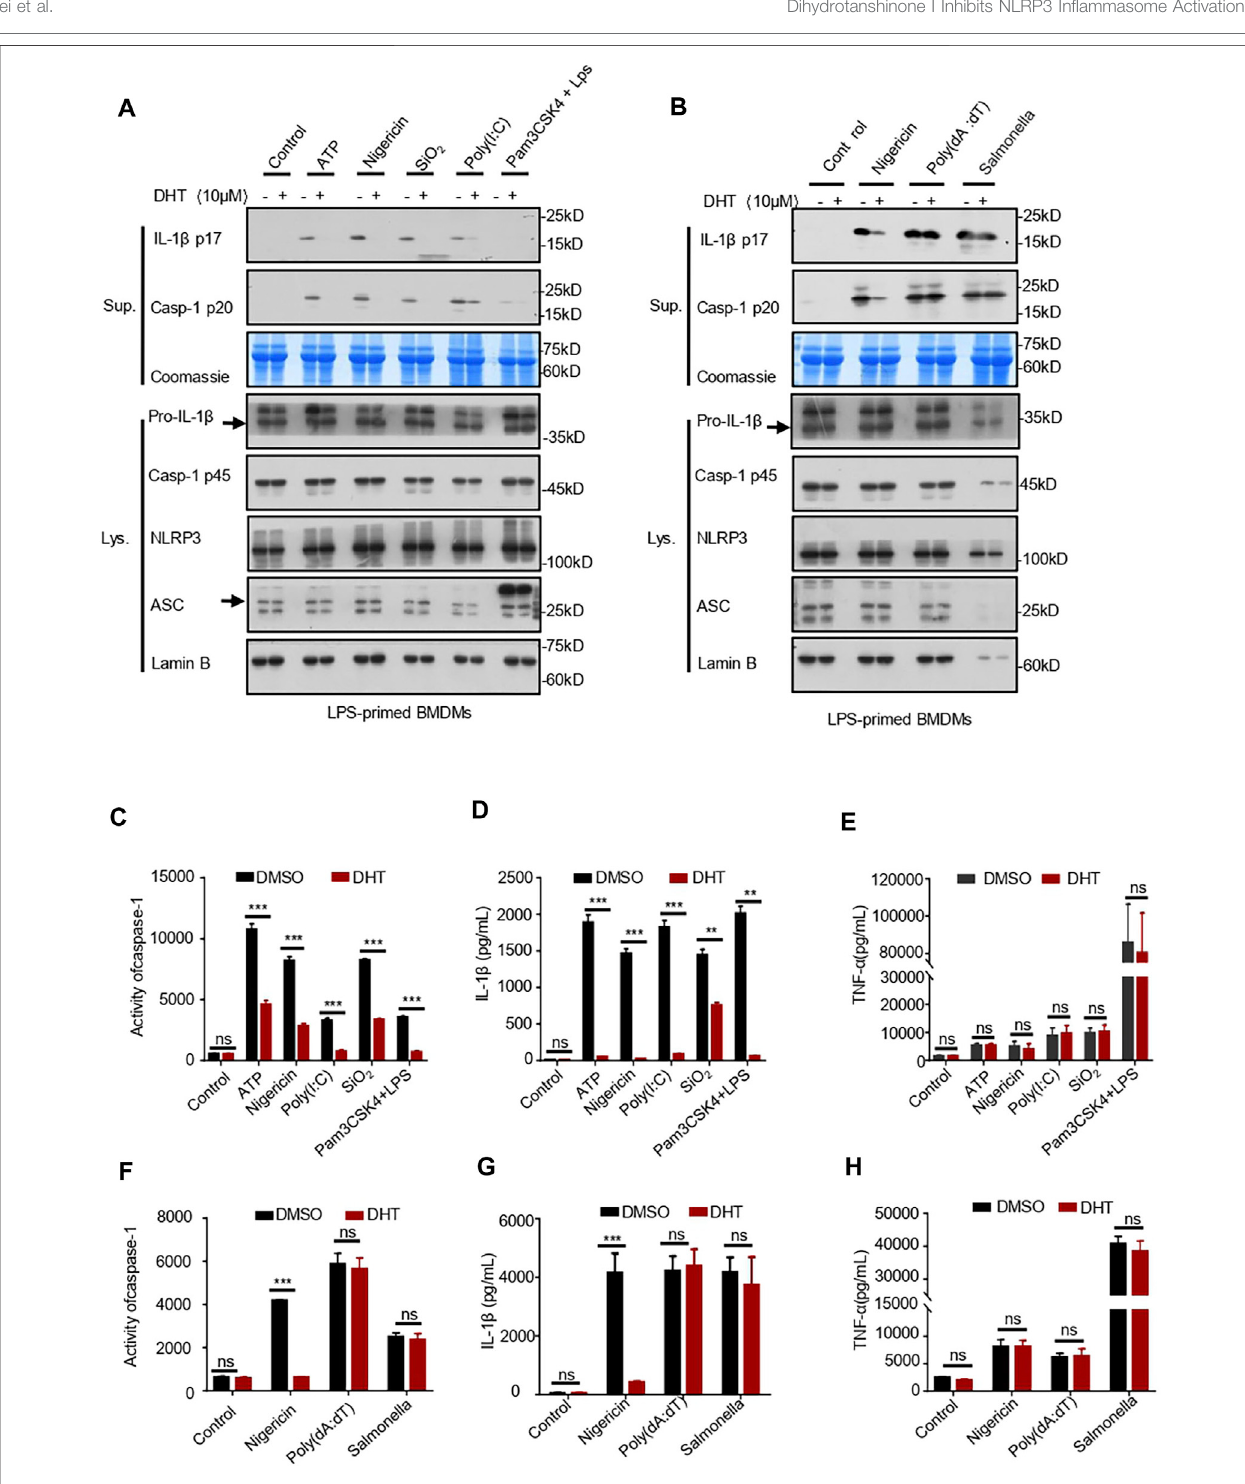
FIGURE 2 | Dihydrotanshinone I speci fi cally inhibits NLRP3 in fl ammasome activation. (A) LPS-primed BMDMs were treated with dihydrotanshinone I (10 μ M) and then stimulated with ATP (45 min), nigericin (30 min), poly (I: C) (6 h), or SiO 2 (6 h), or Pam3CSK4-primed BMDMs were treated with dihydrotanshinone I (10 μ M) and stimulated with LPS (6 h). Western blot analysis of IL-1 β (p17) and caspase-1 (p20) in supernatants (Sup.) and pro – IL-1 β and pro – caspase-1 in whole lysates (Lys.) of BMDMs are shown in (A) . (B) BMDMs were primed with LPS, exposed to DHT (10 μ M), and then stimulated with nigericin, Poly (dA:dT) (6 h), and Salmonella typhimurium (6 h).Immunoblotting analysisofIL-1 β (p17)andcleavedcaspase-1(p20)inculturesupernatants(Sup.)andpro – IL-1 β andpro – caspase-1inwholelysates of BMDMs (Lys.). (C – E) Activity ofcaspase-1 (C) , secretion ofIL-1 β (D) , and production ofTNF- α (E) in Sup. from samples described in (A) . (F – H) Activity of caspase-1 (F) ,IL-1 β (G) ,andTNF- α (H) inSup.fromindicatedsamplesin (B) .Coomassiebluestainingwasusedasthesupernatantloadingcontrol (A – B) andLaminBasthelysate loading control (A – B) . Data are represented as mean ± SEM from three biological replicates. Statistics were analyzed by multiple t-tests. * p < 0.05, ** p < 0.01, *** p < 0.001, NS: not signi fi